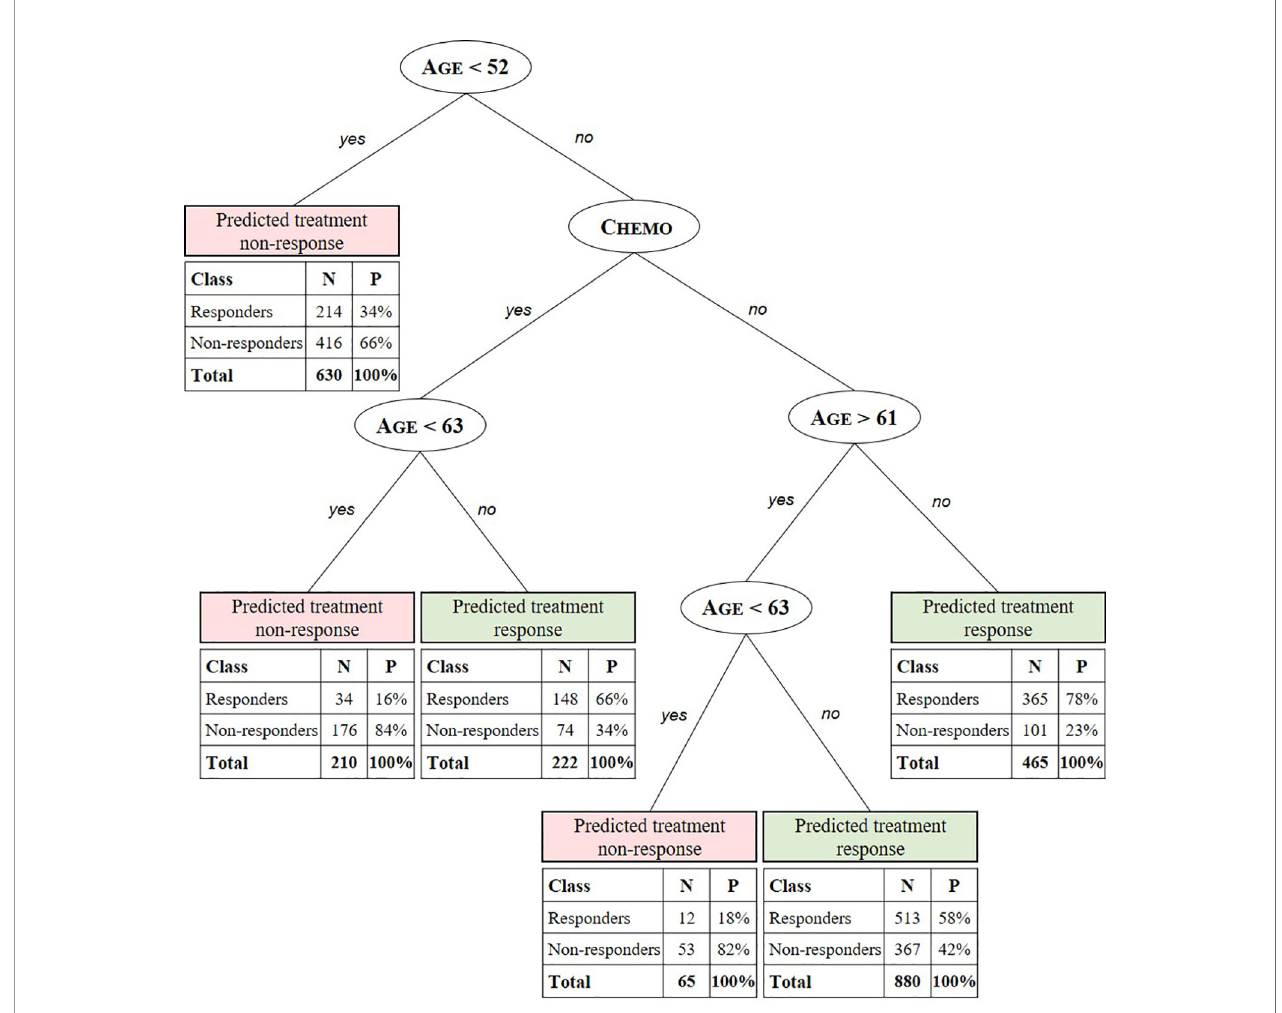
FIGURE 2 | Summary predictive classi fi cation tree model after training and validation. Predicted strati fi cation variables for TMZ in glioblastoma include age, RPA class, and chemotherapeutic (Chemo) and radiotherapeutic (RT) patient status. For each strati fi ed patient class a confusion matrix indicates the number (N) and percentage (P) of treated patients from the test set for which the CT predicts treatment response correctly (responders to predicted treatment response and non- responders to predicted non-response) with respect to the labeled SG value. E.g. the CT model predicts the class of patients aged 52 to 61 years and >63 years not receiving concomitant or adjuvant chemotherapy to respond to the treatment with a true positive (TP) probability of 58%. For this class, with patients aged < 63 years 82% are correctly predicted (true negative [TN]) not to